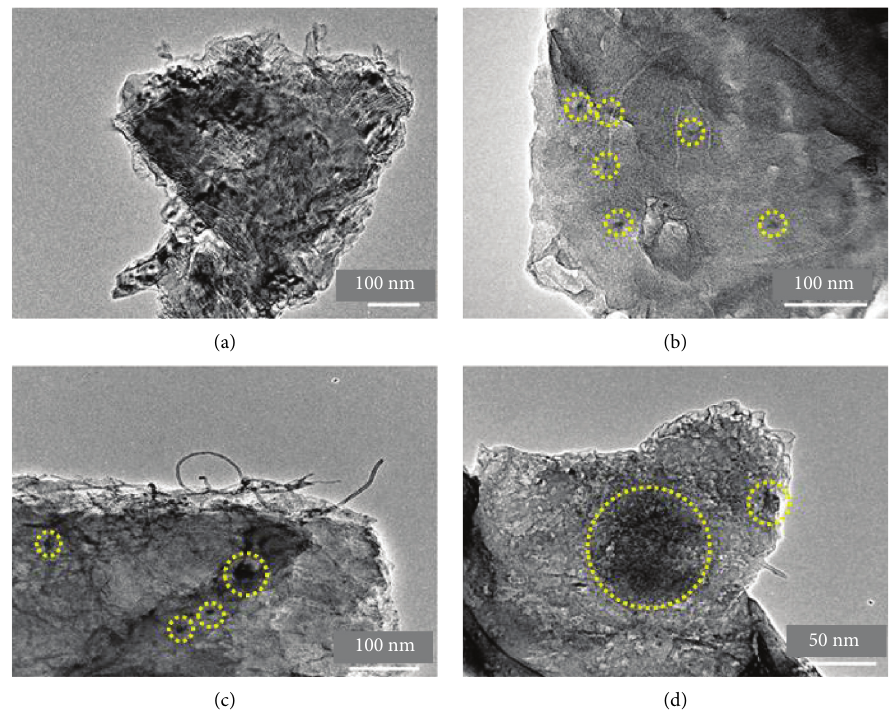
Figure 5: TEM images of (a) LiOH · H